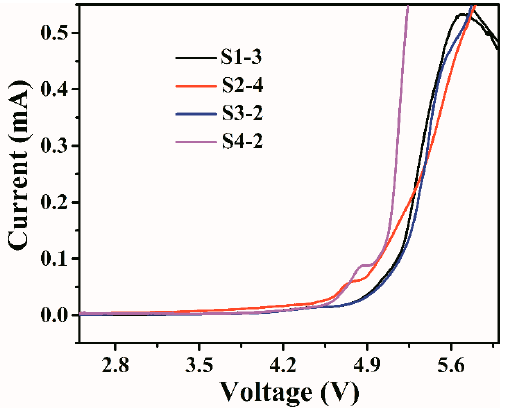
Figure 6. LSV curves of GPEs prepared by different mixed solvents.